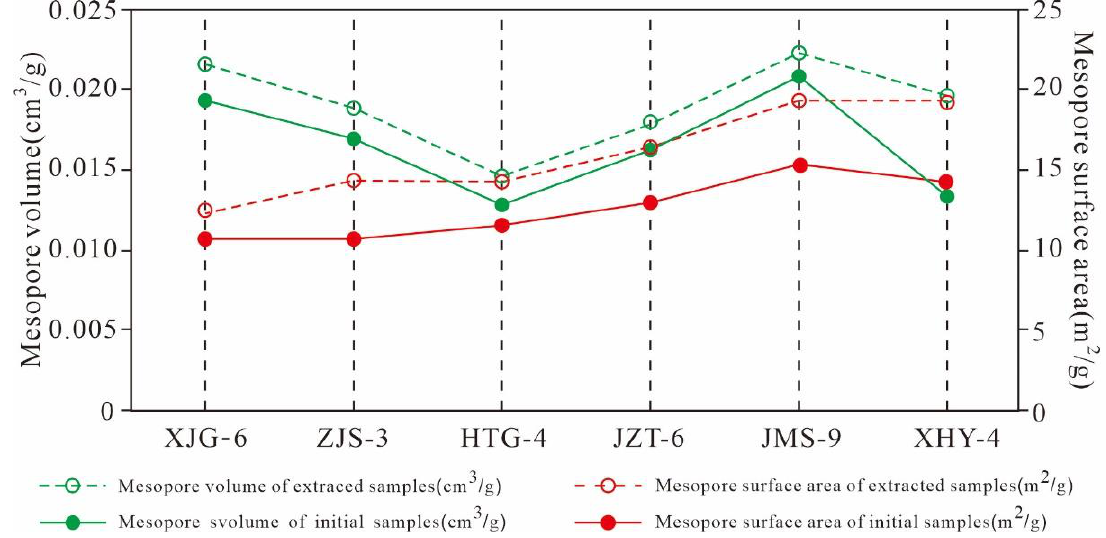
Figure 25. Mesopore SA and PV variation characteristics of the original shale and its corresponding extracted samples.